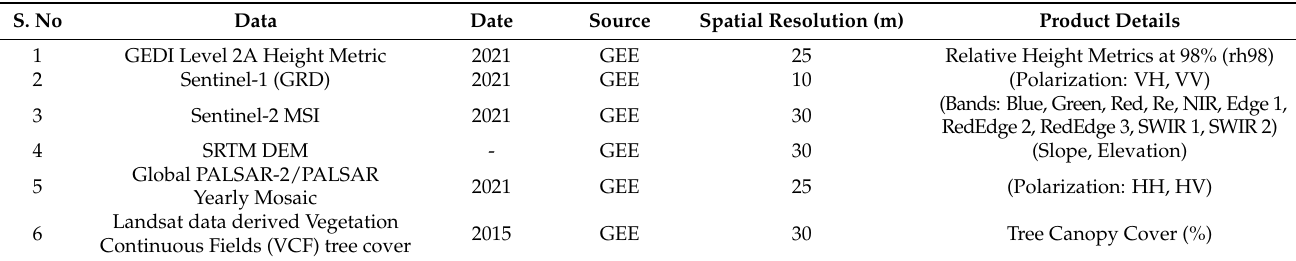
Table 2. List of data used in the